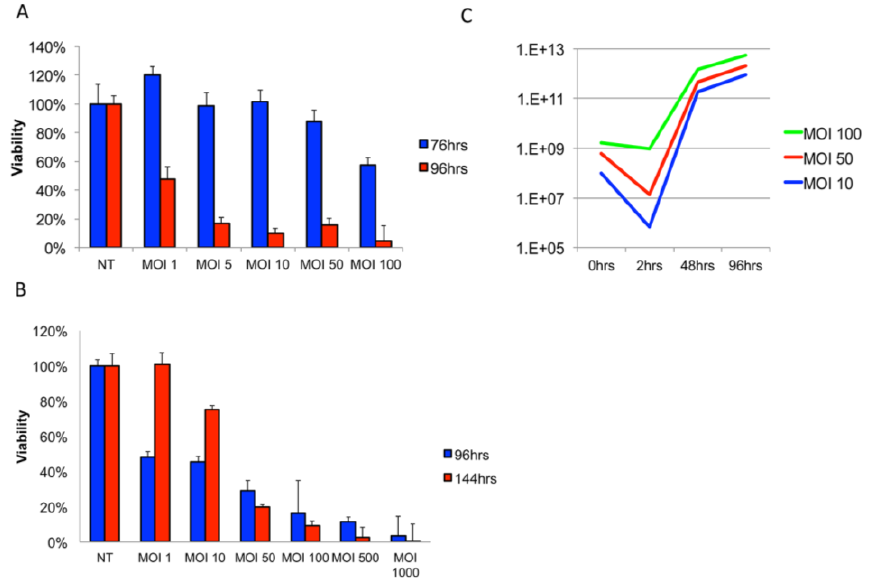
Figure 1. Delta24-RGD effectively infects, replicates and amplifies in Jurkat T-cells. ( A ) Viability assay on MGG8-GSC neurospheres infected with a dose range of Delta24-RGD; ( B ) viability assay on Jurkat T-cells infected with a dose range